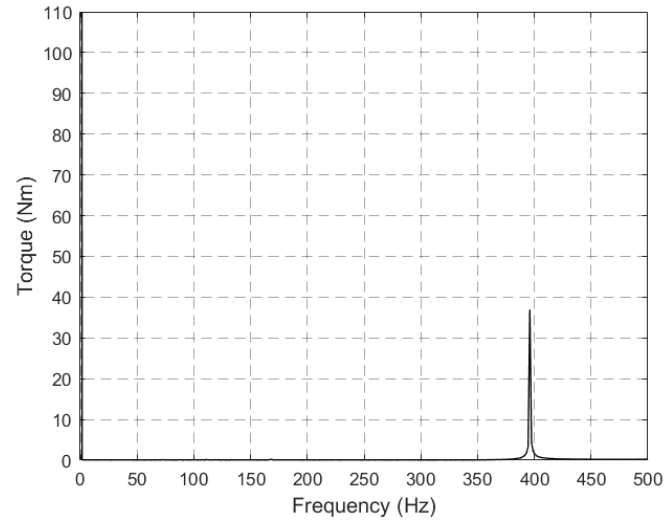
Figure 15. Torque amplitude frequency spectrum, f ∈ (0, 500 Hz).